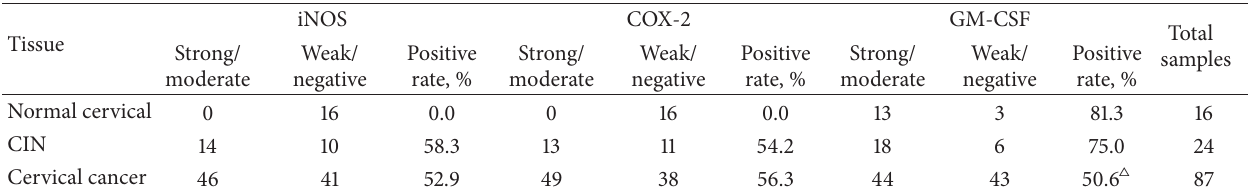
Table 1: Expression of GM-CSF, COX-2, and iNOS proteins in normal cervical, CIN, and cervical cancer tissues.